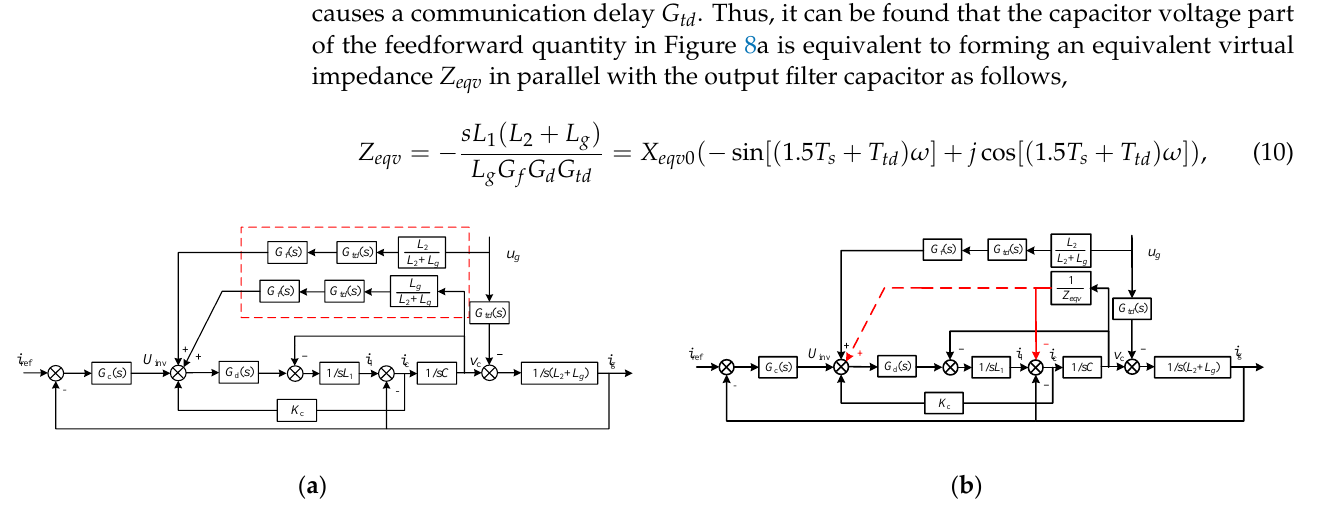
Figure 8. Equivalent virtual impedance of grid voltage feedforward control scheme. ( a ) Before simplification; ( b ) After simplification.